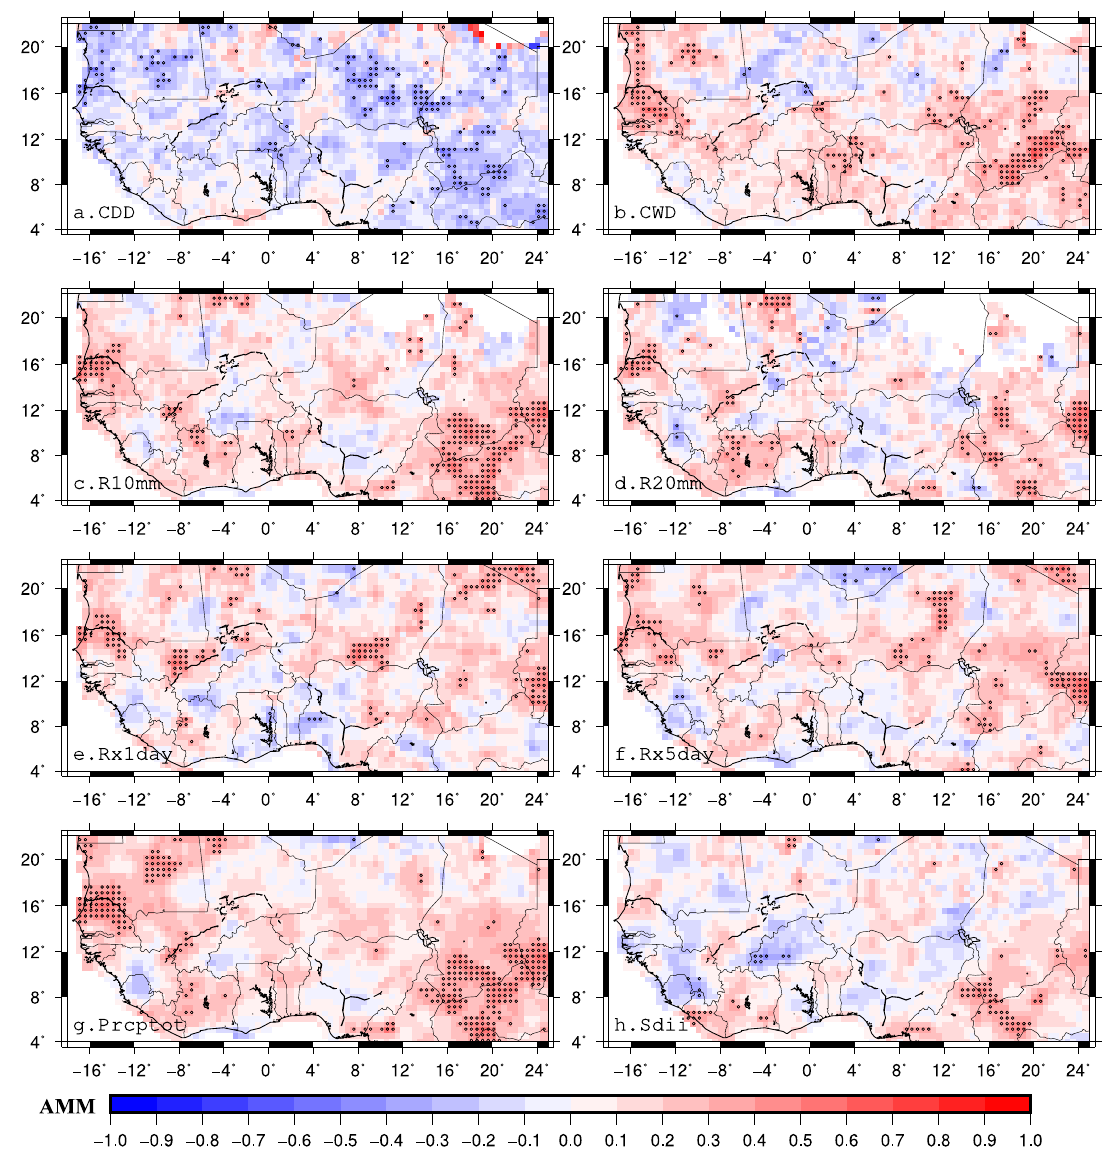
Figure 4. Correlation matrix between West Africa sub-regions extreme precipitation indices and remote climate indices. ( a ) West Africa subregions delimitation, ( b ) correlation between averaged extreme precipitation indices in West Africa and remote indices, ( c – g ) correlation between averaged extreme precipitation indices in subregions and remote indices.